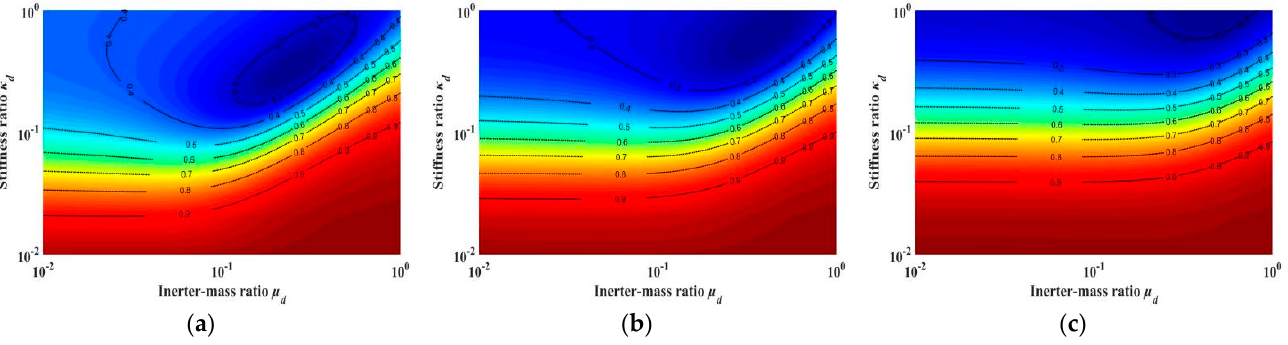
Figure 9. 2D Contour plot of γ Ur of SC system: ( a ) ζ d = 0.05; ( b ) ζ d = 0.10; and ( c ) ζ d = 0.15.